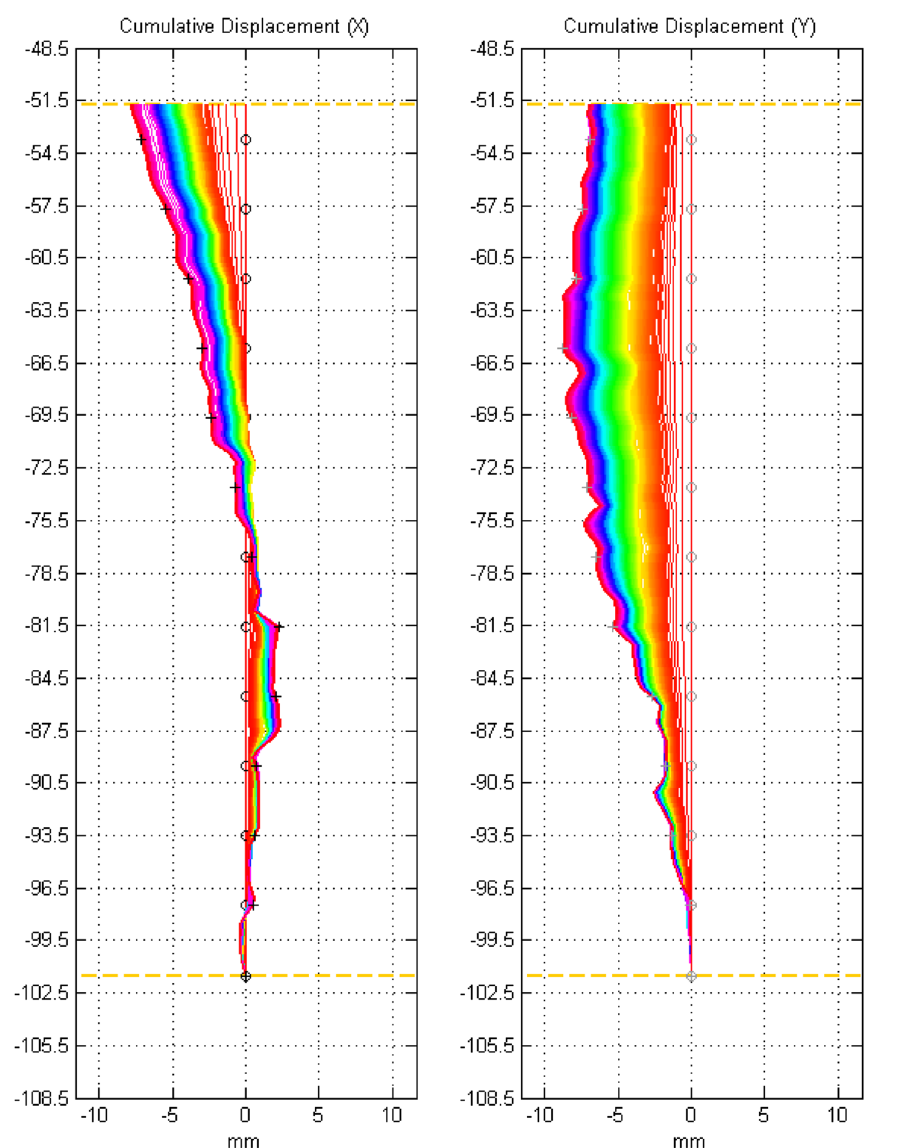
Fig. 5 Graph of cumulative displacement X , Y from the SSASuite